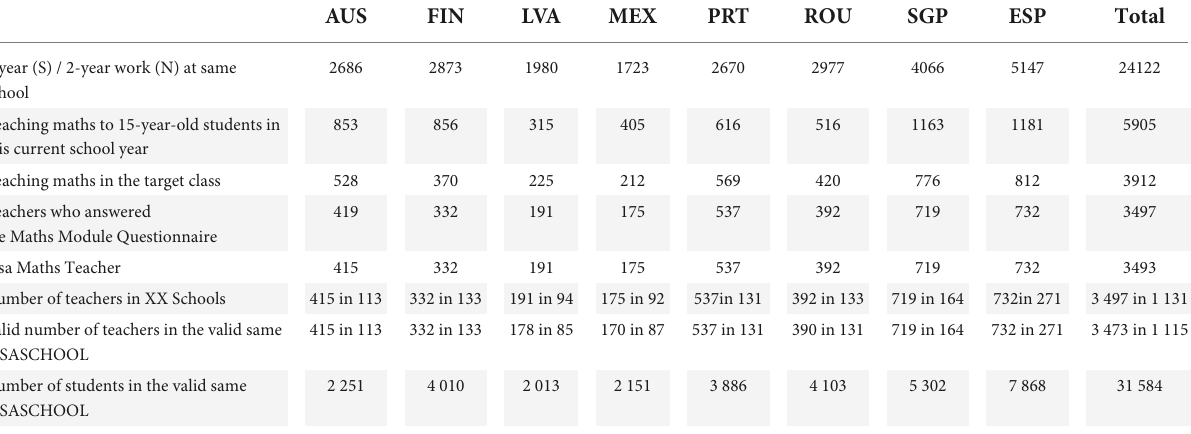
TABLE 4 Overview of redesign TALIS-PISA Link database (rTPL).